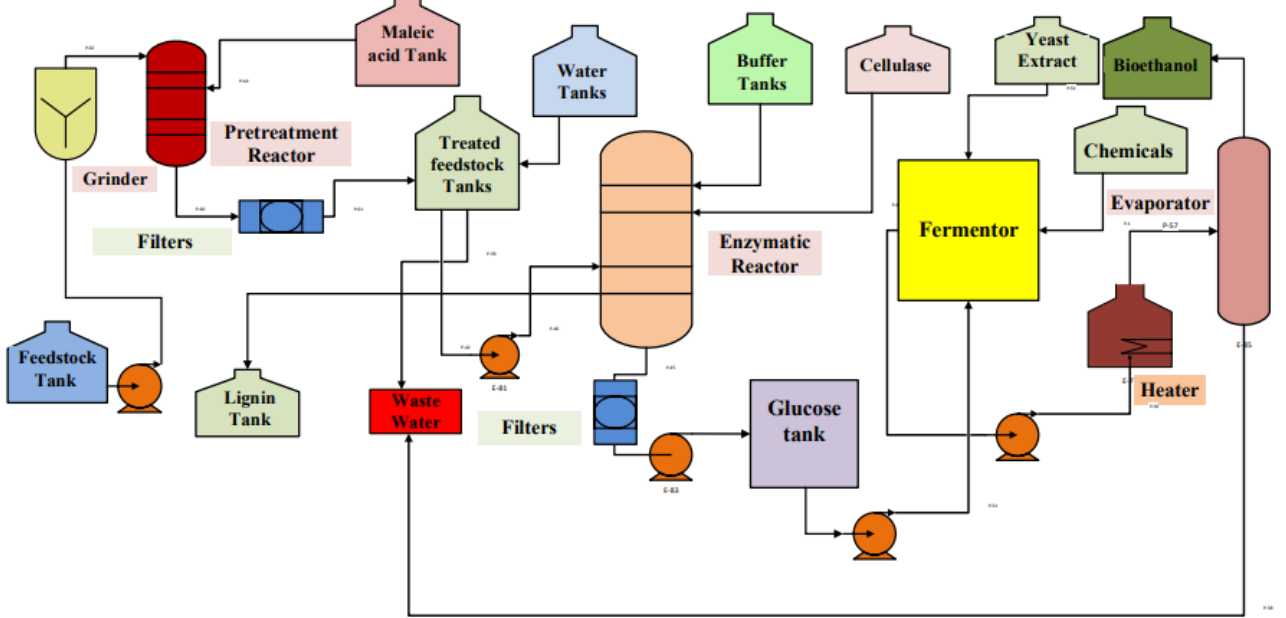
Figure 15. Process flow diagram of bioethanol production.